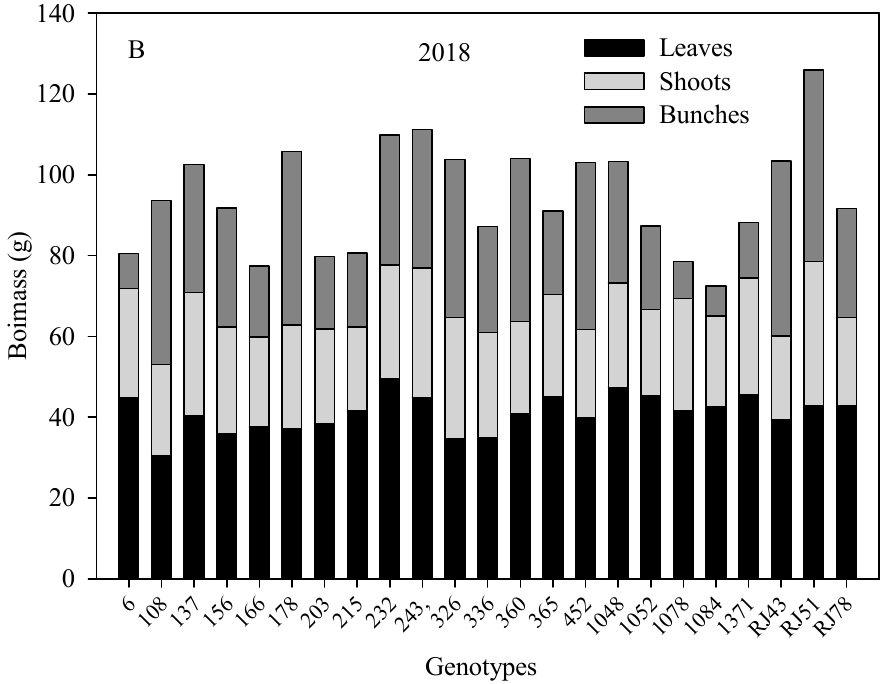
Figure 3. Total dry biomass divided in leaves (black bars), shoots (grey bars) and bunches (dark bars) measured at the end of experiments in 2017 ( A ) and 2018 ( B ) for each genotype (N = 5).